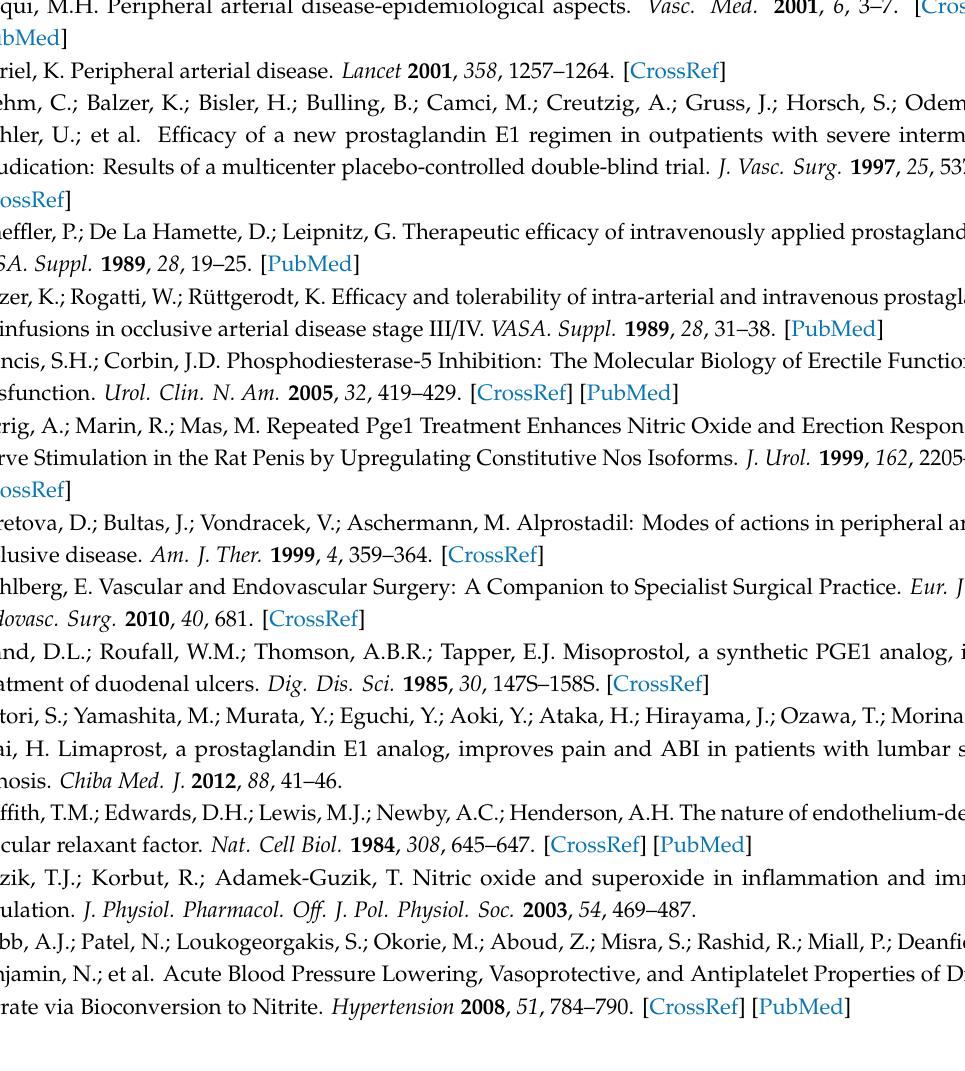
Supplementary Materials: The following are available online, Table S1: Retention time and MRM parameters for prostaglandin profiling, Table S2: Retention time and MRM parameters for purine and pyrimidine profiling, Table S3: Retention time and MRM parameters for steroid profiling, Table S4: Retention time and MRM parameters for amino acid profiling, Table S5: Validation parameters for the studied metabolites, Table S6: The reaction of Prostanit and PGE 1 with NO detection